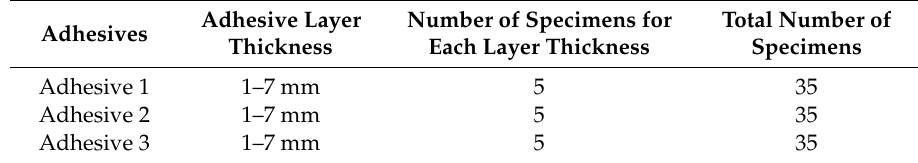
Figure 3. Control of each adhesive layer’s thickness. Table 1. Test variables and number of specimens.